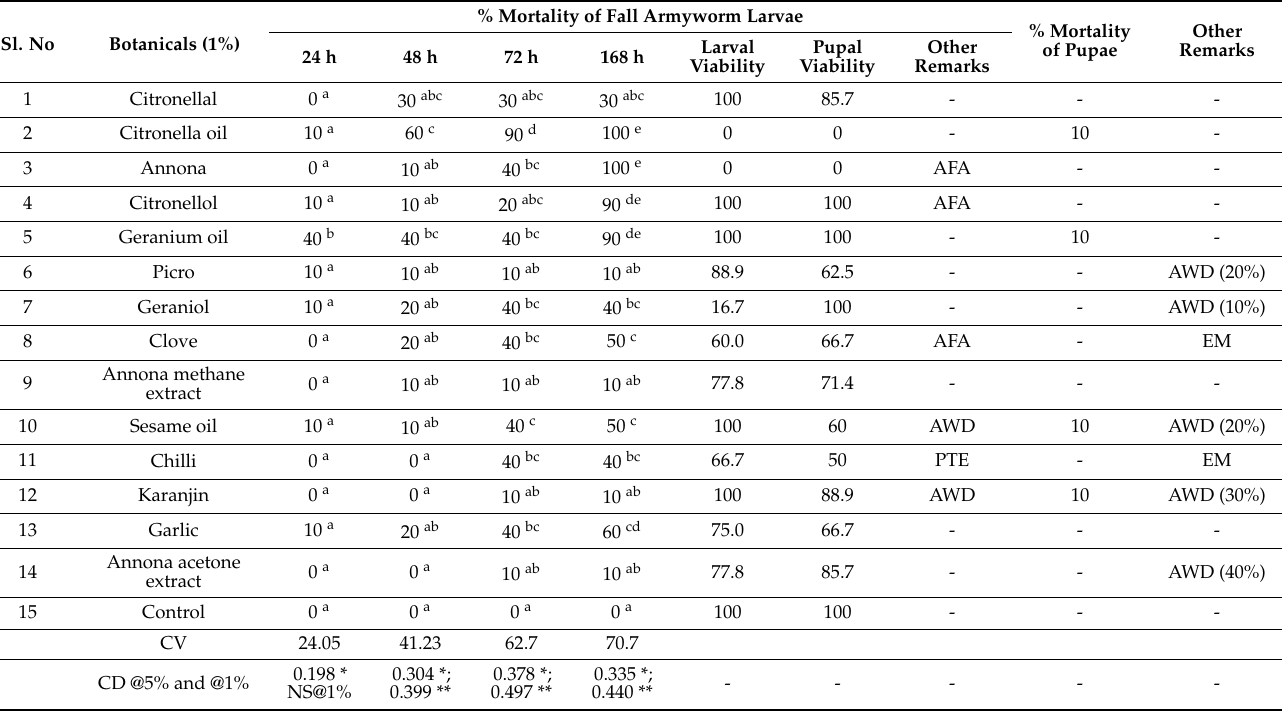
Table 4. Percent mortality of larvae and pupae of Fall Armyworm after exposure to different